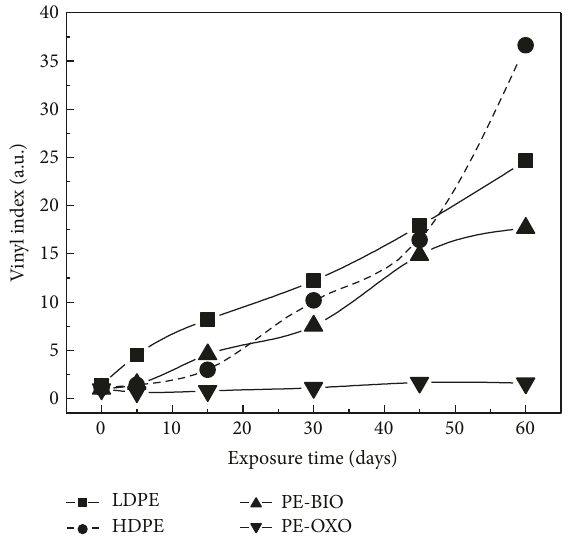
Figure 5: Dichroic ratio of the LDPE ( ◼ ), HDPE ( e ), PE-BIO ( 󳵳 ), and PE-OXO ( 󳶃 ) films exposed to UV-B